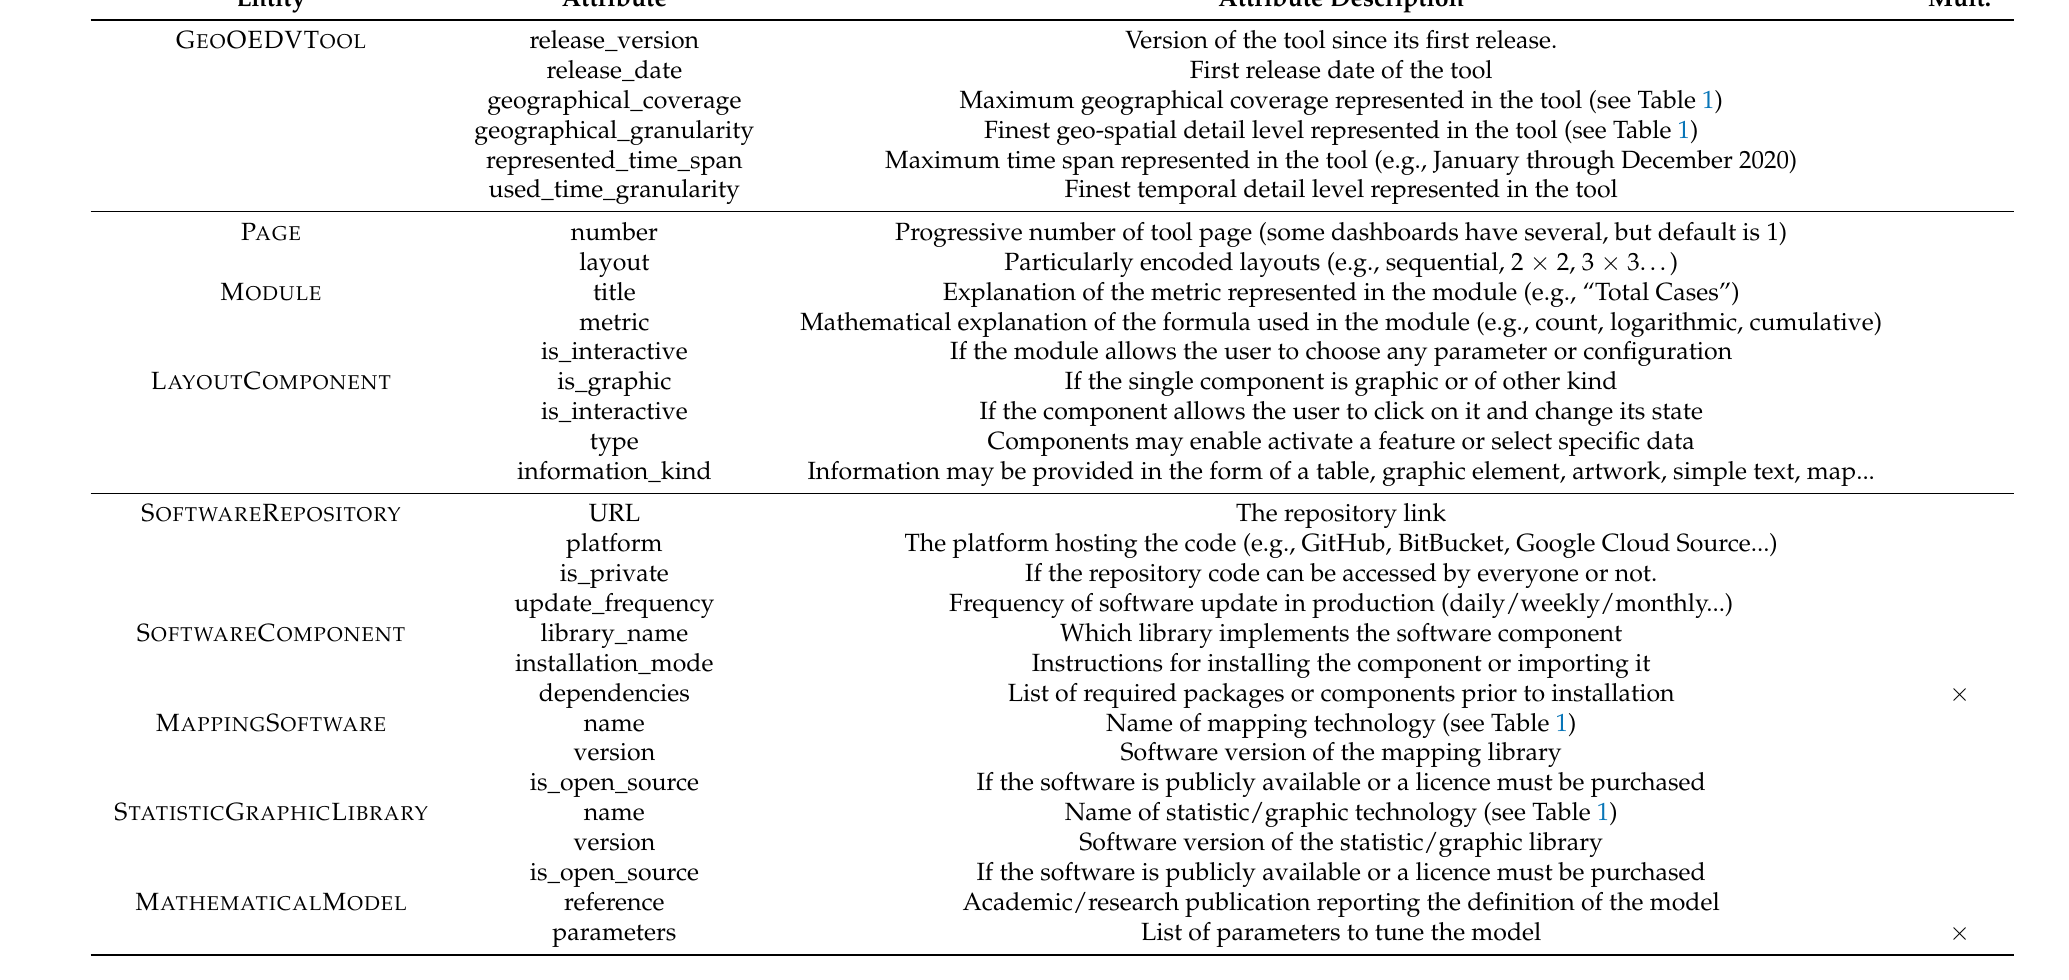
Table 2. Comprehensive list of ER diagram attributes, grouped by their corresponding